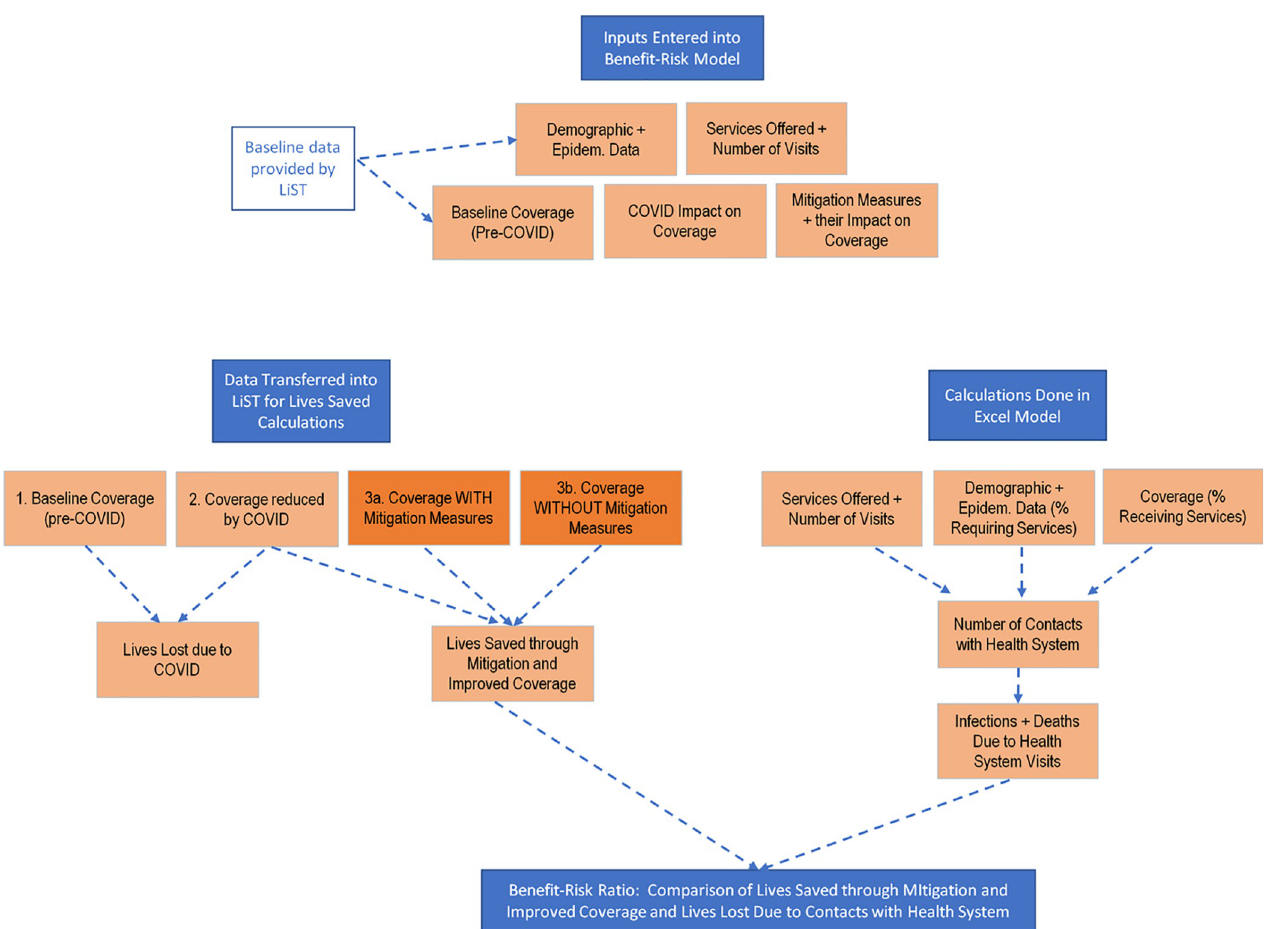
Fig 2. Model flowchart: Data input and calculations � . � Flowchart describes the overall processes used to input data and enter data into models, and to calculate benefit of maintaining services, risk of infection, and final benefit risk ratio.